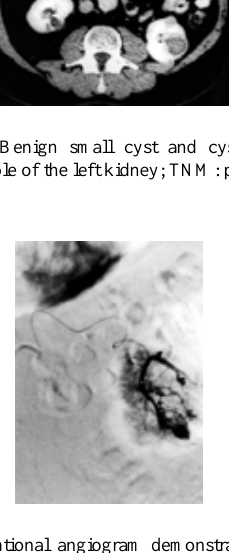
FIGURE 2 . Pre-interventional angiogram demonstrates an arterial blush at the lower pole of the kidney at the site of former nephron sparing surgery.